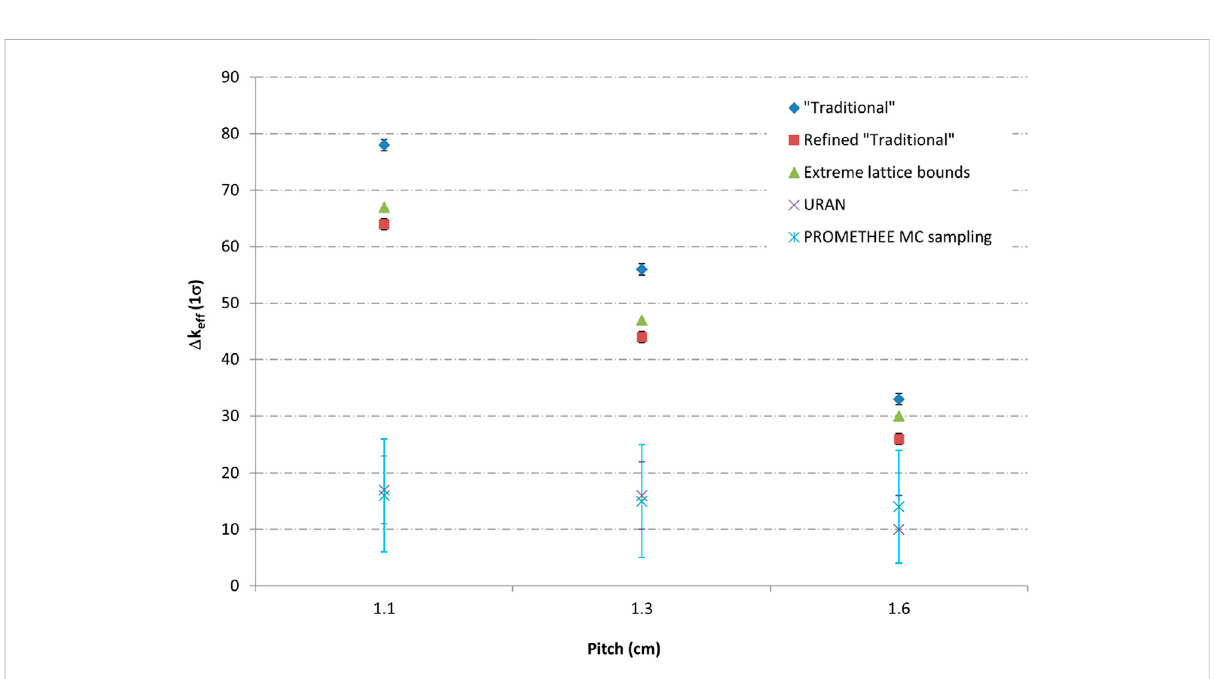
FIGURE 9 Results comparison of the different methods with MORET 5